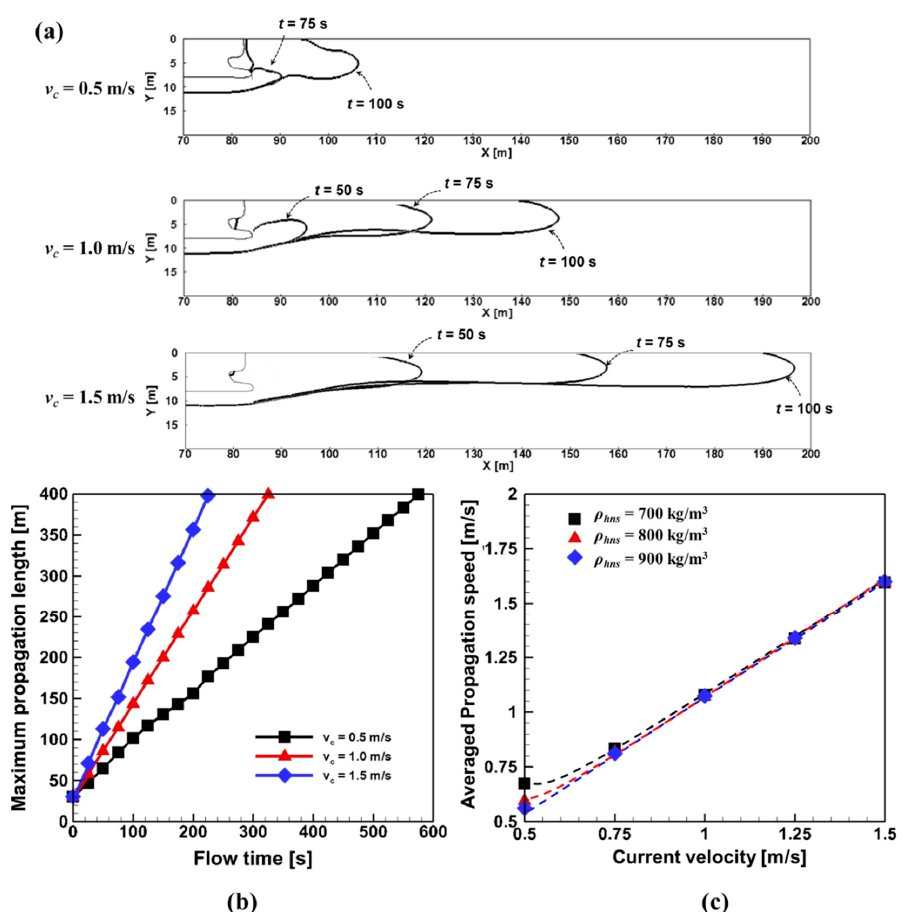
Figure 6. ( a ) The movement of the interface from 50 to 100 s for different current velocities with ρ hns = 700 kg/m 3 , ( b ) the maximum x location of HNS interface in the case of ρ hns = 700 kg/m 3 , and ( c ) the averaged HNS propagation velocity for the input variables ( v c and ρ hns